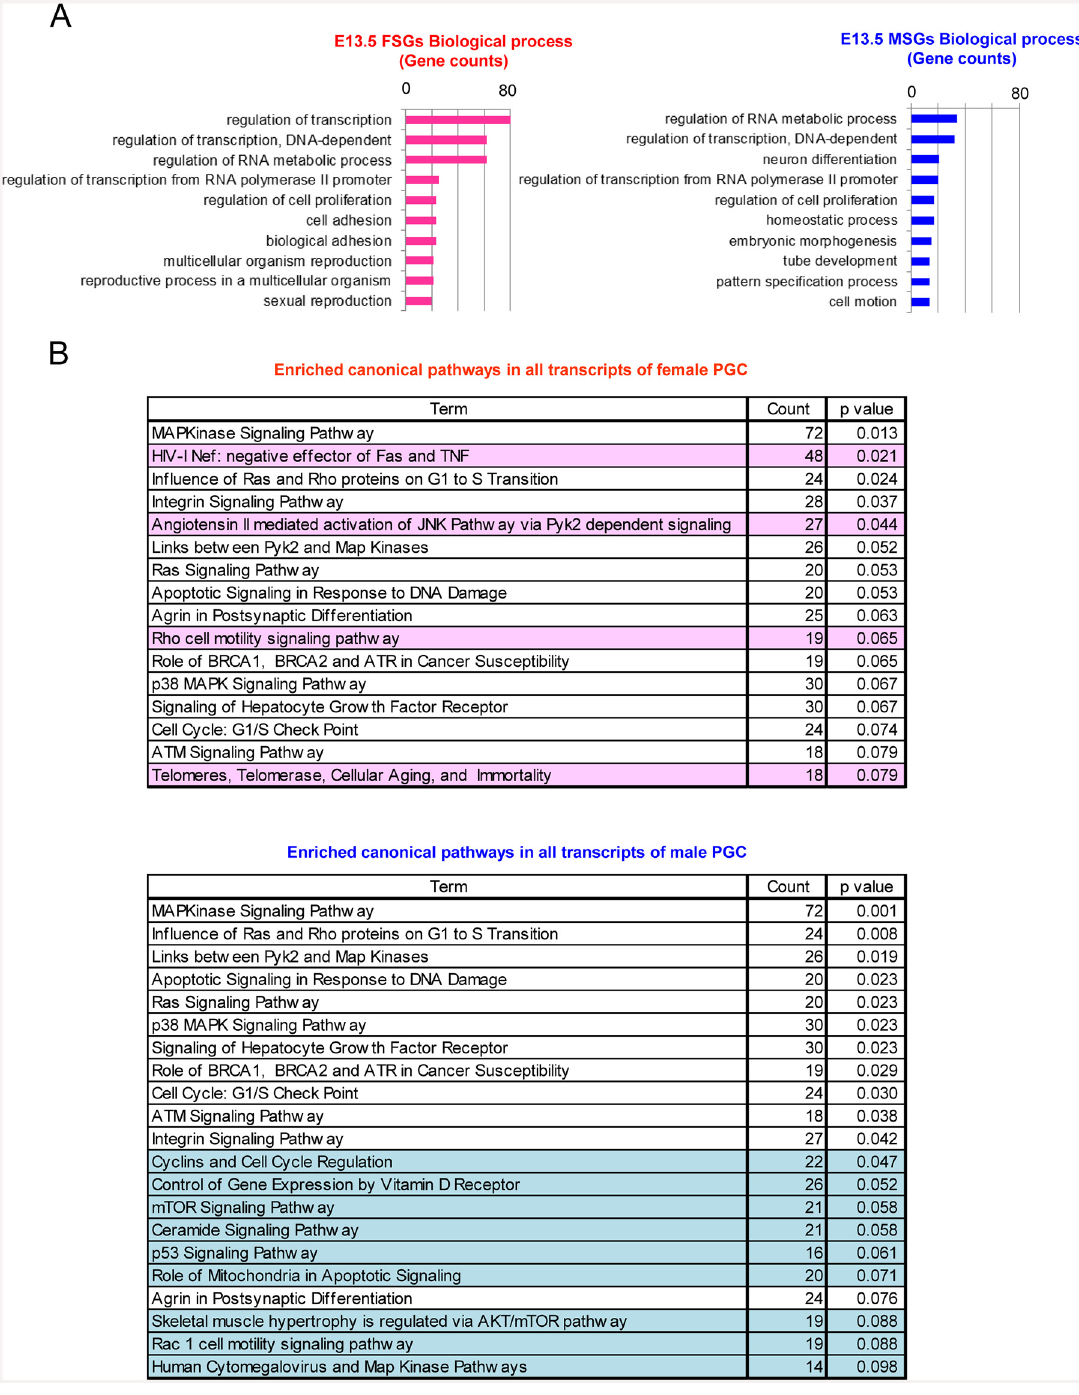
Fig 3. Biological significance of female and male-specific PGC-expressed genes. (A) GO enrichment analysis of FSGs and MSGs. The most highly enriched biological processes based on their respective gene counts are shown (Fisher ’ s exact test: cut-off < 0.1). (B) Pathway analysis of all transcript lists in female and male PGCs. The lists indicate enriched pathways observed among female and male transcripts, as determined using DAVID (Fisher ’ s exact test: cut-off < 0.1). Sex-specific pathways are highlighted in pink and blue, which denote female- and male-specific, respectively.